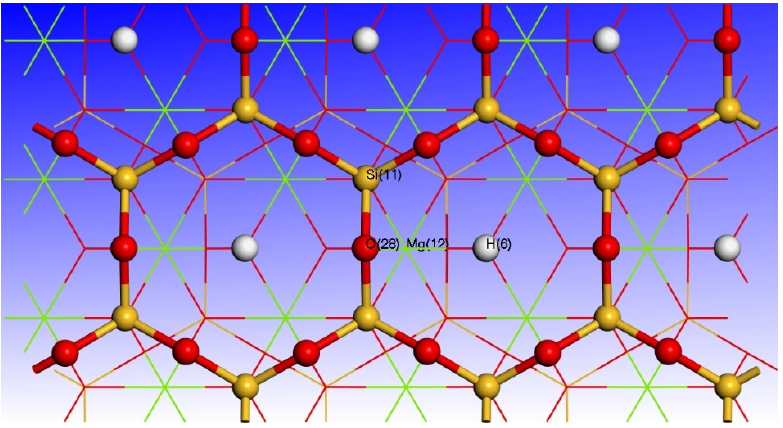
Figure 2. Emmetropia of the (2 × 2 × 1) supercrystal cell on talc (001) surface under ideal condition. Table 2. Surface parameters of ideal talc (001) and with point defects.